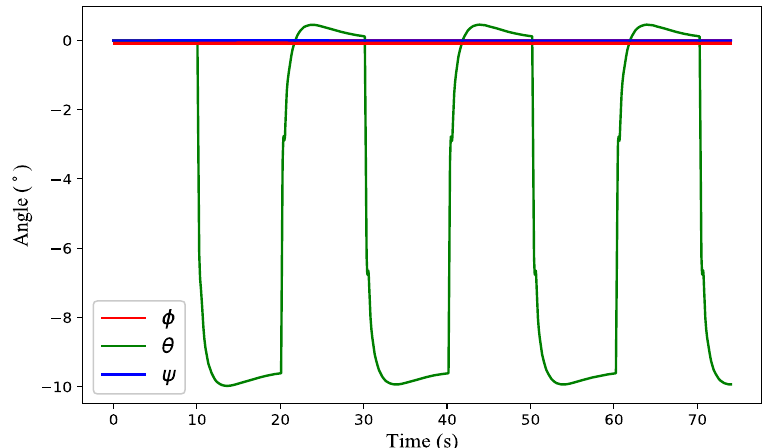
Figure 7. Attitude variation of the quadrotor when encountering gust.